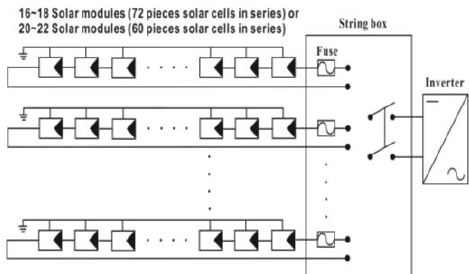
Figure 3. Typical electrical topology of sub-array for the studied photovoltaic power stations. 16~18 or 20~22 crystalline silicon solar modules were concatenated into module string. A string box with direct current switch was used to connect the module strings in parallel. The string box was directly concatenated to solar inverter. The aluminium frame of solar module was grounded for the sake of preventing electric shock.